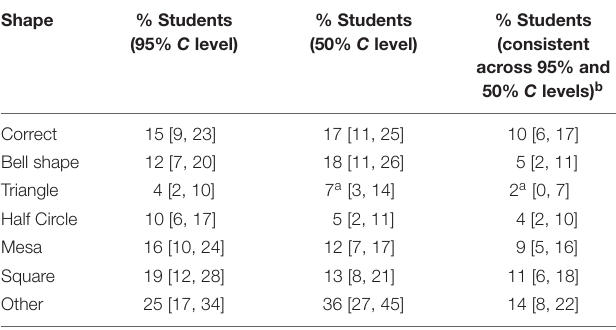
TABLE 1 | Percentage [and 95% CIs] of students with each shape in Task